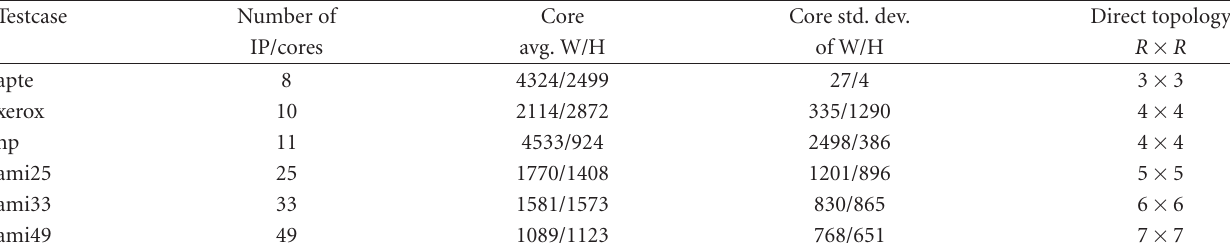
Table 1: Characteristics of the used testcases.